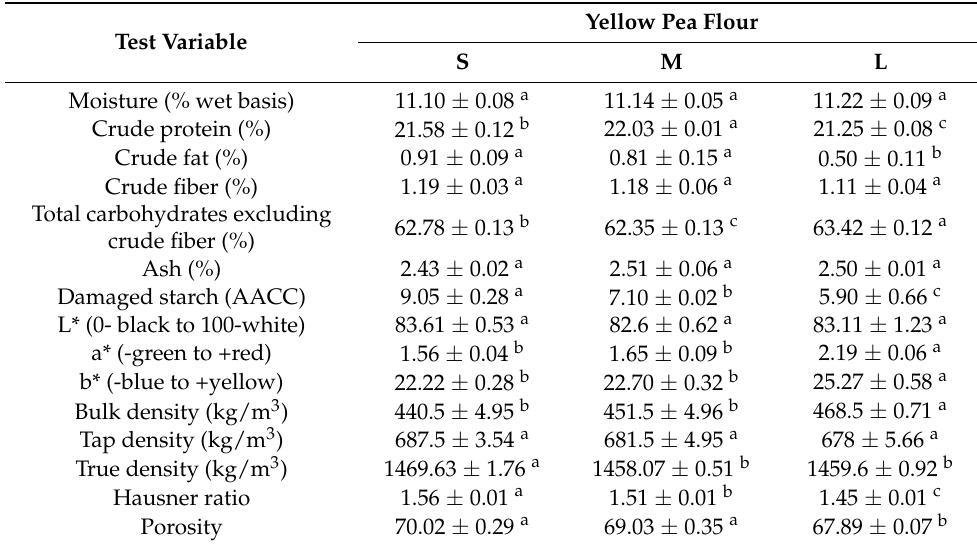
Table 5. Physicochemical properties of yellow pea